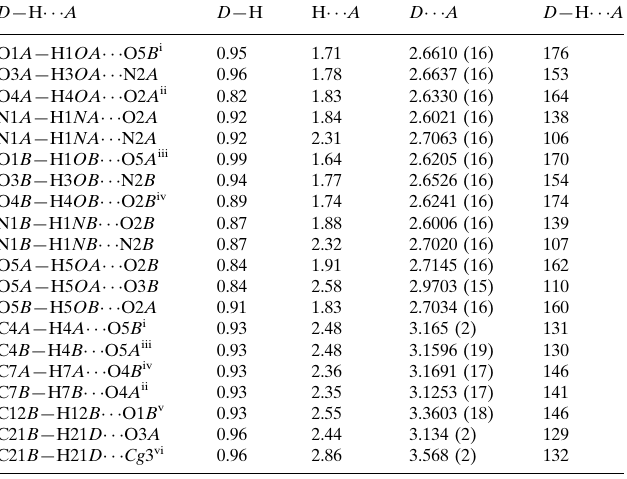
Hydrogen-bond geometry (A˚ , (cid:2) ). D —H (cid:1)(cid:1)(cid:1)